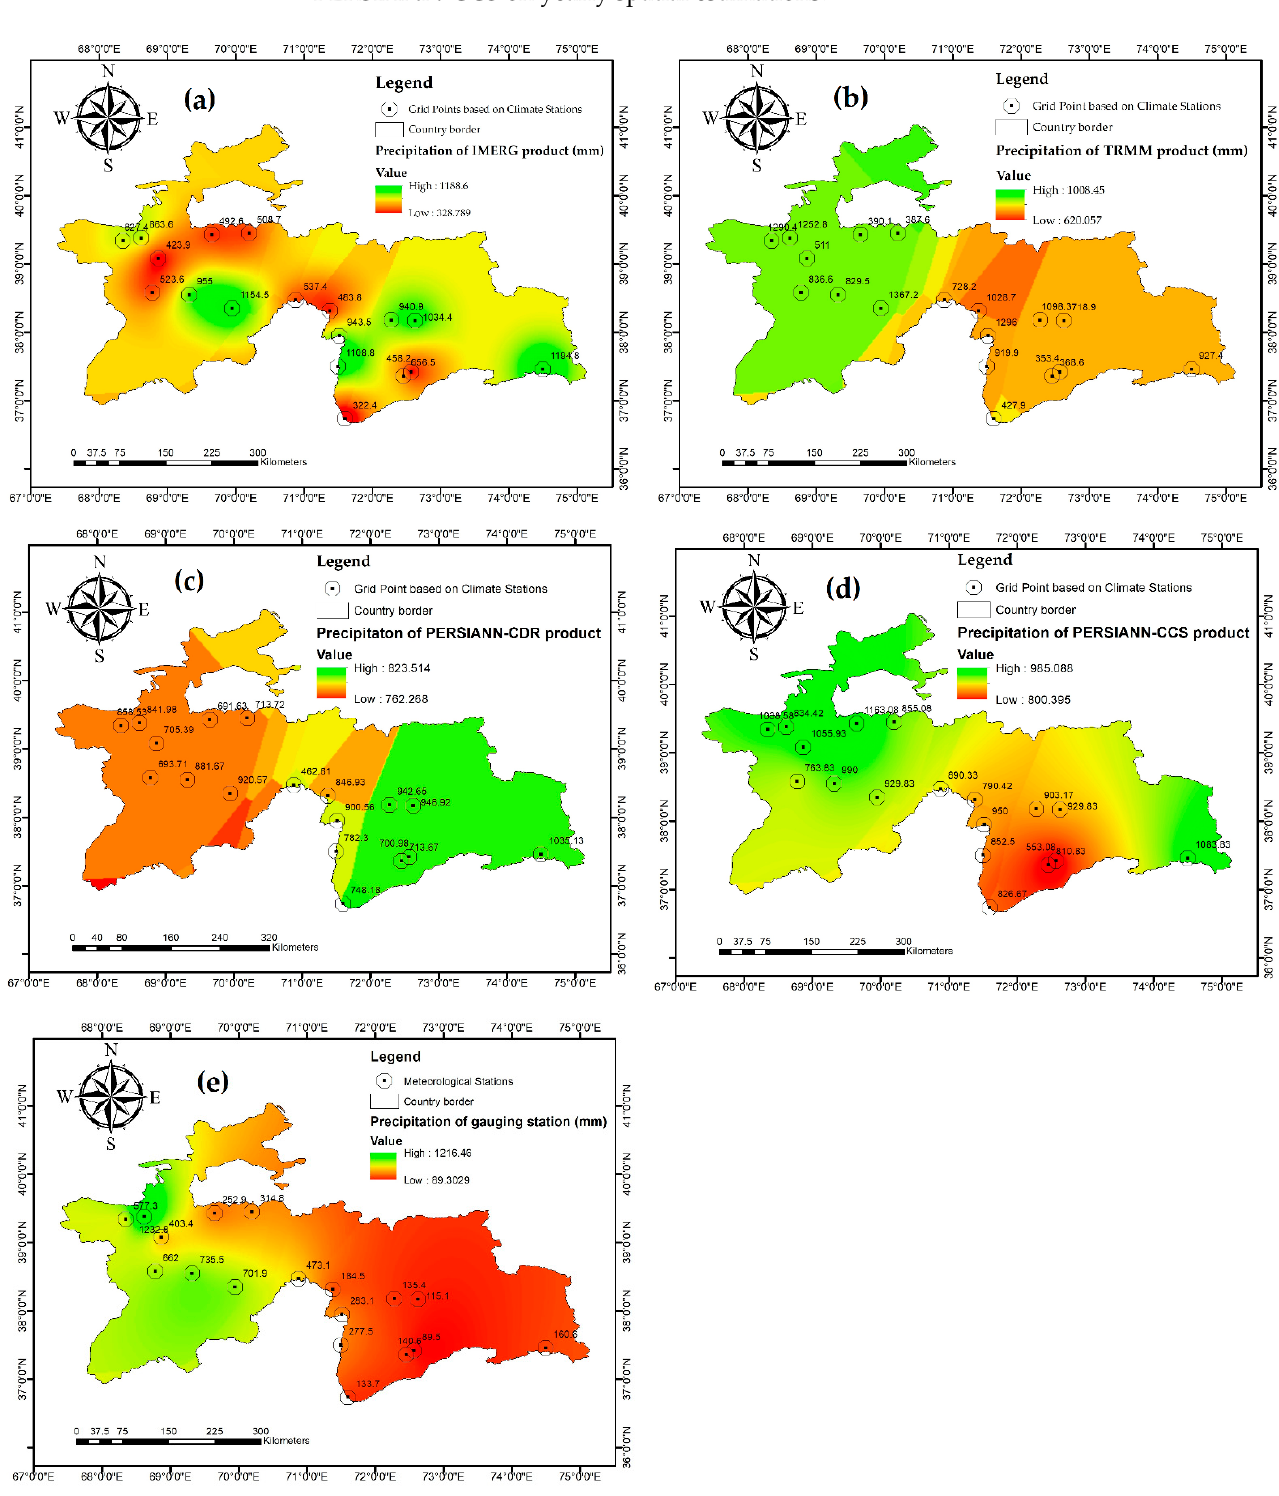
Figure 4. Distribution of annual precipitation datasets based on ( a ) IMERG, ( b ) TRMM, ( c ) PERSIANN-CDR, ( d ) PERSIANN-CSS, and ( e ) gauging stations using the Kriging method in the mountainous territories of Tajikistan in Central Asia.